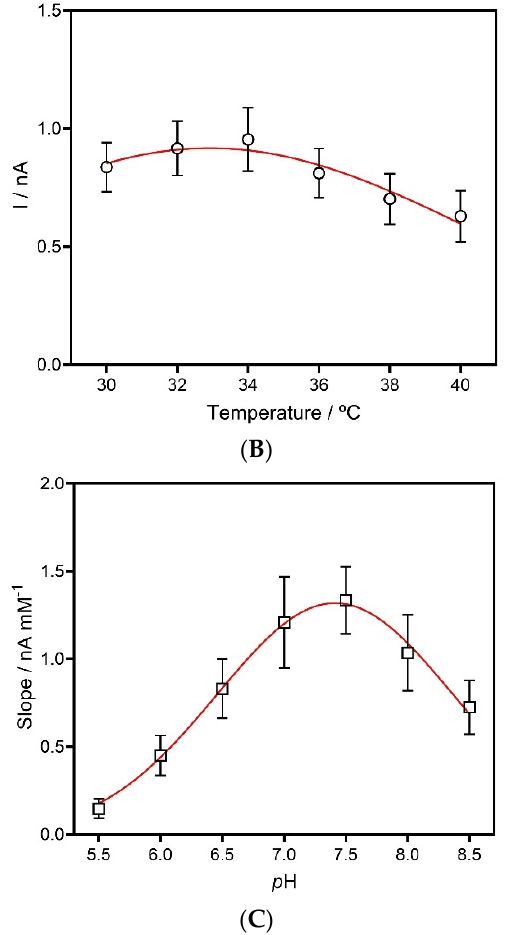
Figure 3. Evaluation of ( A ) oxygen, ( B ) temperature and ( C ) pH dependence of lactate microbiosensor. ( A ) Average normalized current detected by the CFM/Pt/Nafion ® -LOx(0.5%)/PU biosensor to two lactate concentrations (0.5 and 1.0 mM) as function of oxygen concentration. ( B ) Effect of temperature on the recorded current of the CFM/Pt/Nafion ® -LOx(0.5%)/PU biosensor in response to 0.5 mM of lactate. ( C ) Effect of pH on the sensitivity of CFM/Pt/Nafion ® -LOx(0.5%)/PU biosensor towards lactate. Data represent mean ± SEM ( n = 4).